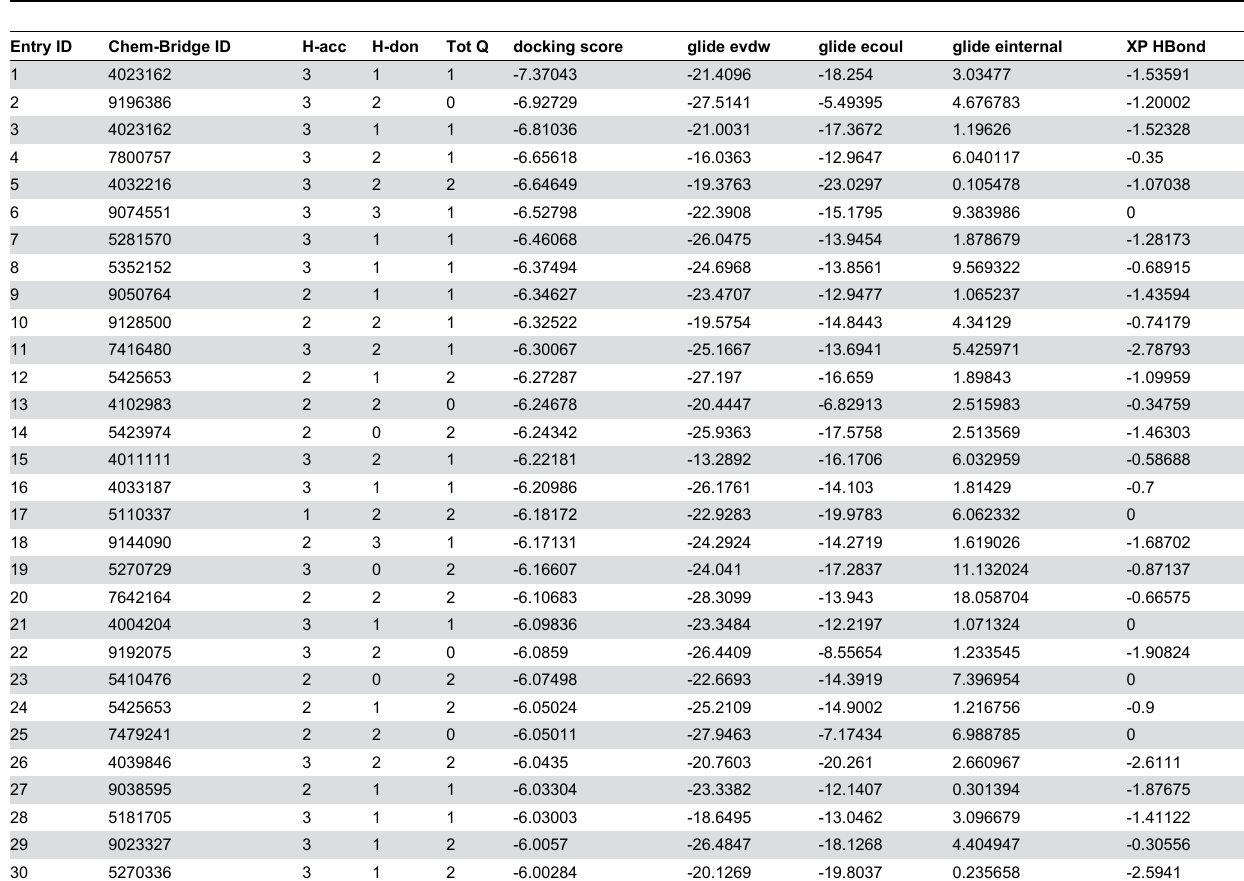
Table 2. Summary of docking results with docking fragments having a glide score less than -6